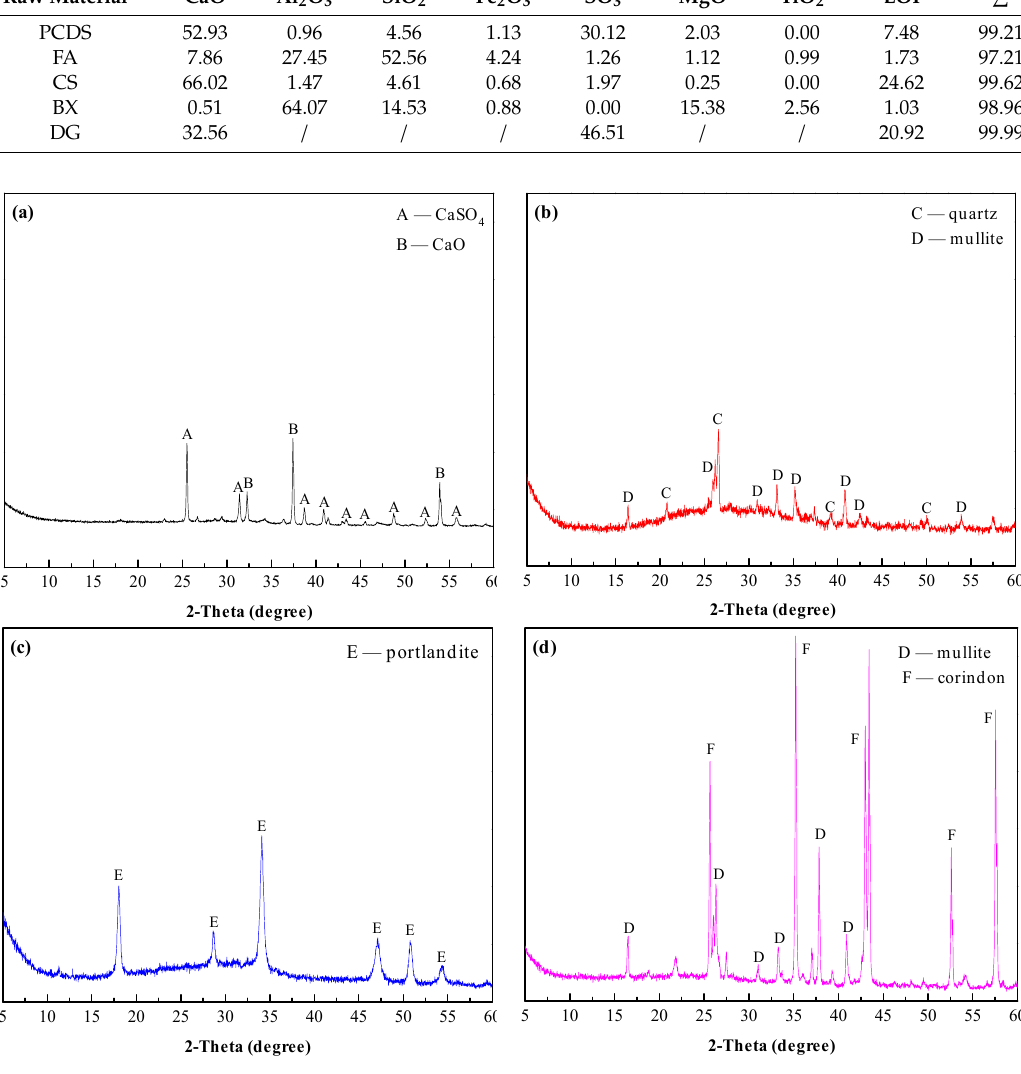
Figure 1. XRD patterns of raw materials: ( a ) PCDS; ( b ) FA; ( c ) CS; ( d ) BX.